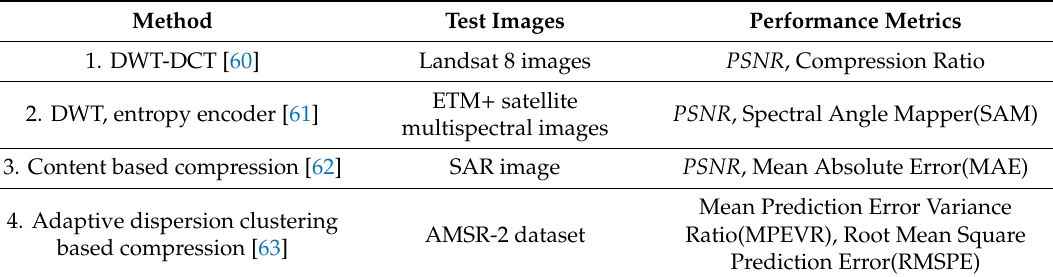
Table 5. Image compression methods and their performance